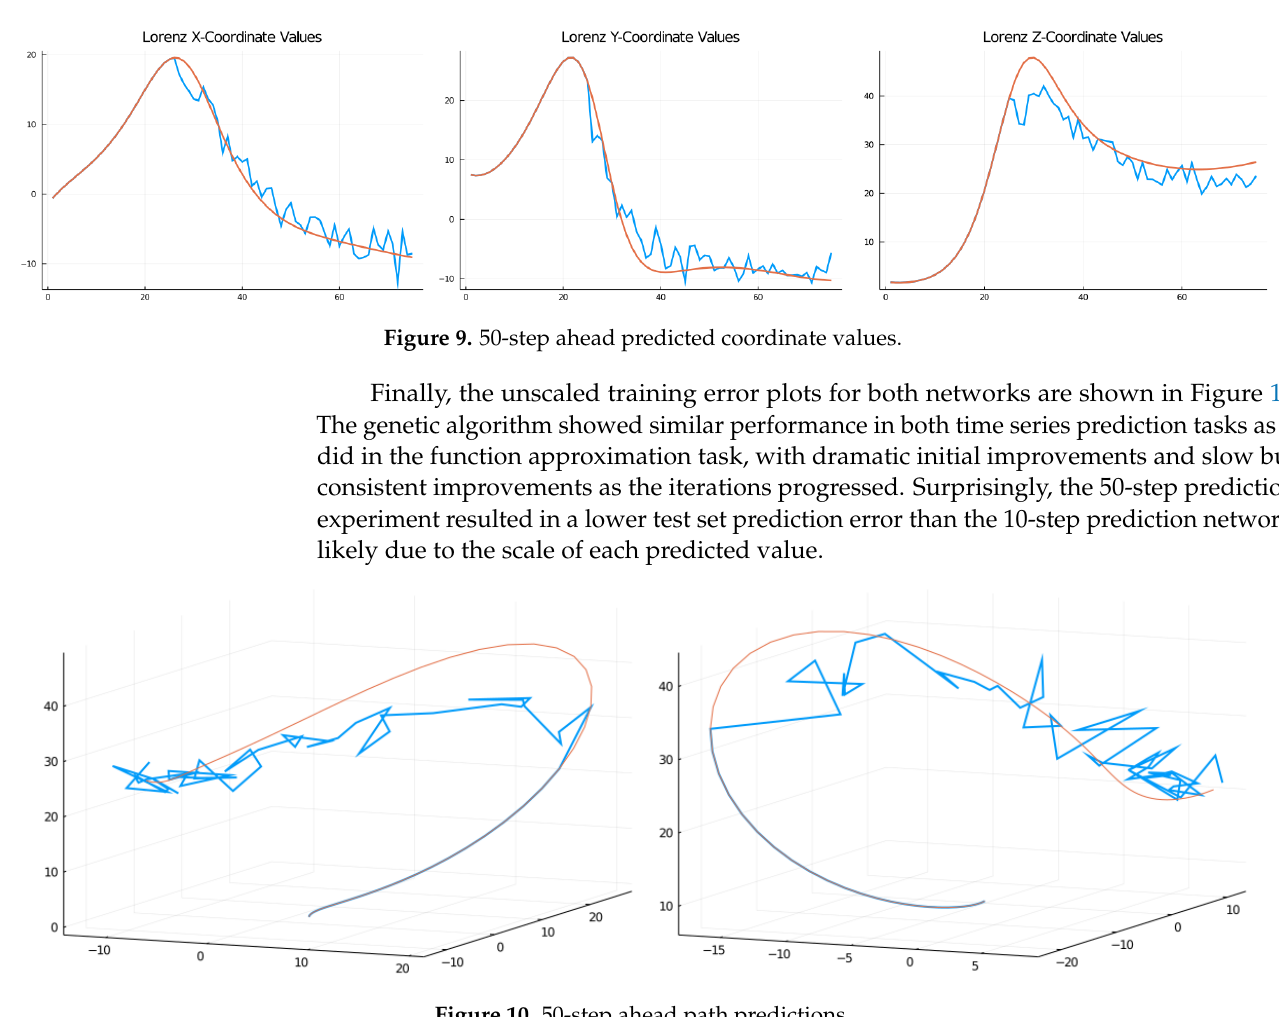
Figure 10. 50-step ahead path